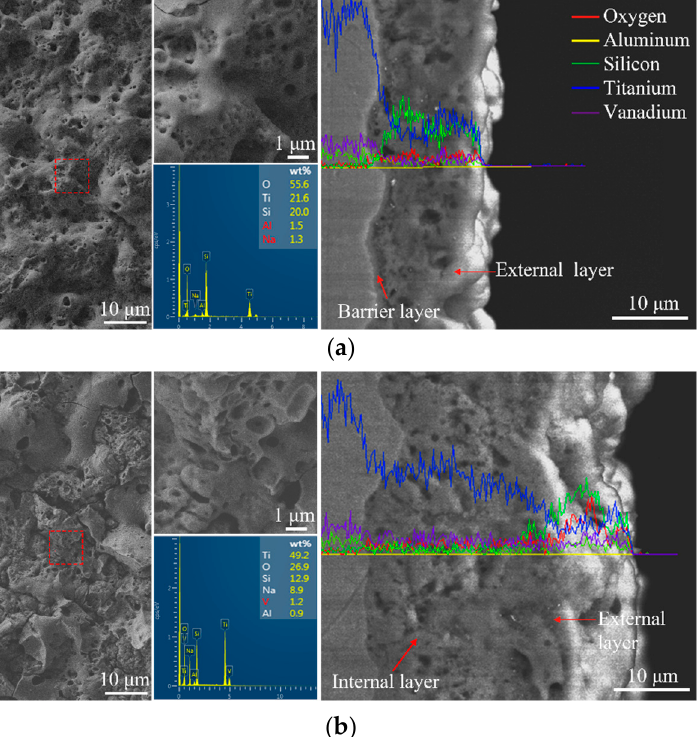
Figure 6. Surface morphology, cross-sectional morphology, and the corresponding EDS element distribution of the coating obtained by performing the MAO treatment in the Na 2 SiO 3 electrolyte for ( a ) 1200 and ( b ) 12,000 s.